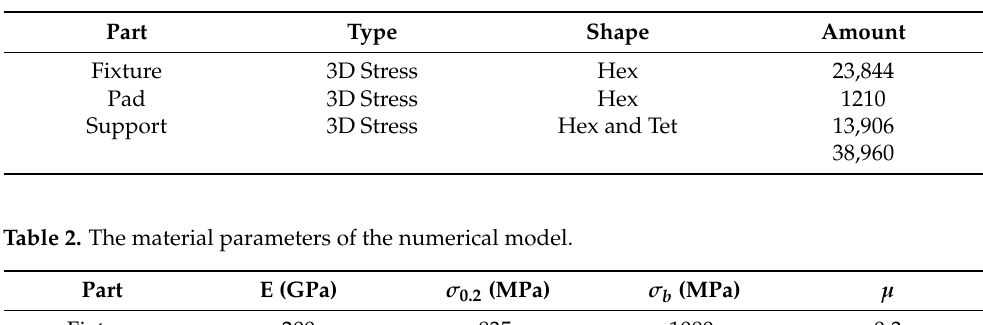
Table 2. The material parameters of the numerical model.